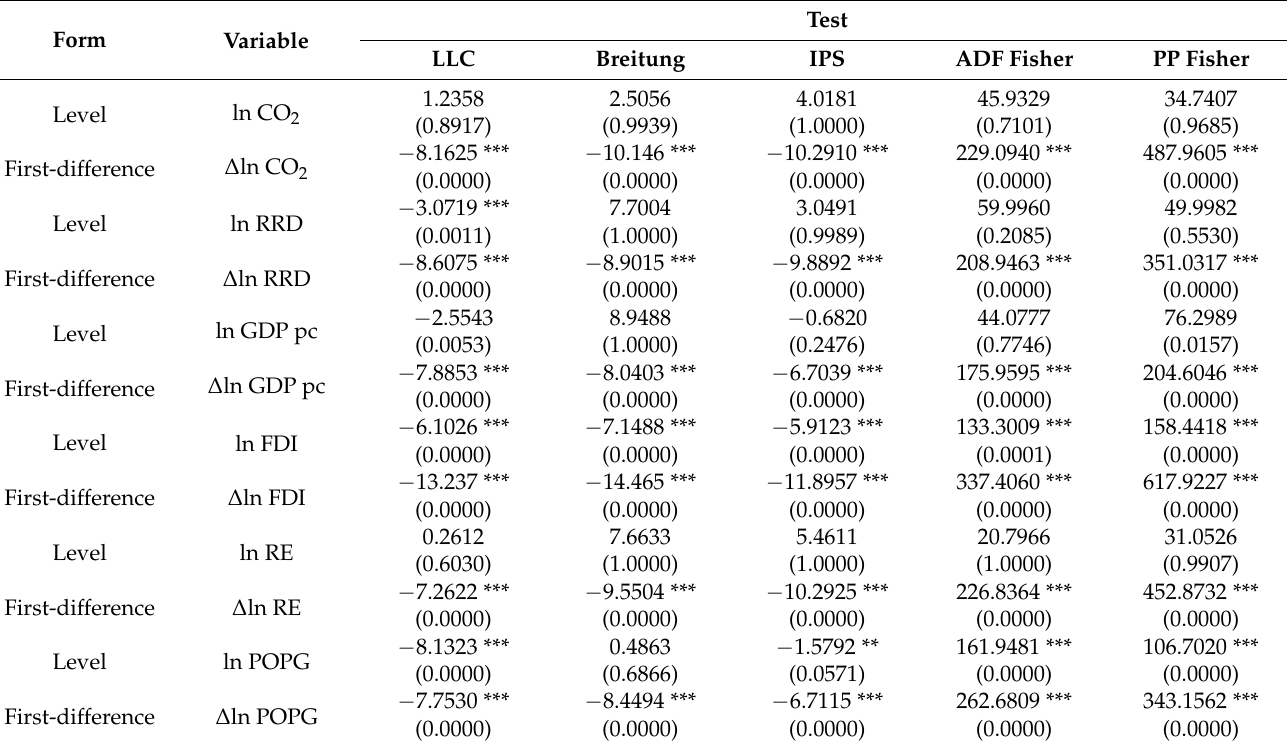
Table 2. Panel unit root test